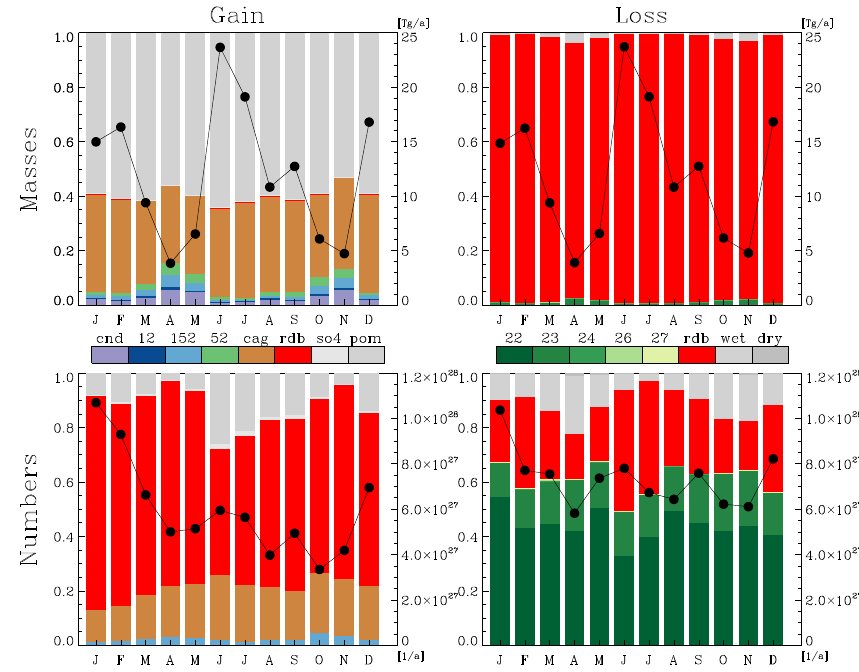
Figure 12. Seasonal cycle of regional tendencies of the hydrophilic Aitken mode over the Savanna (see Fig. 1). The colored bars show